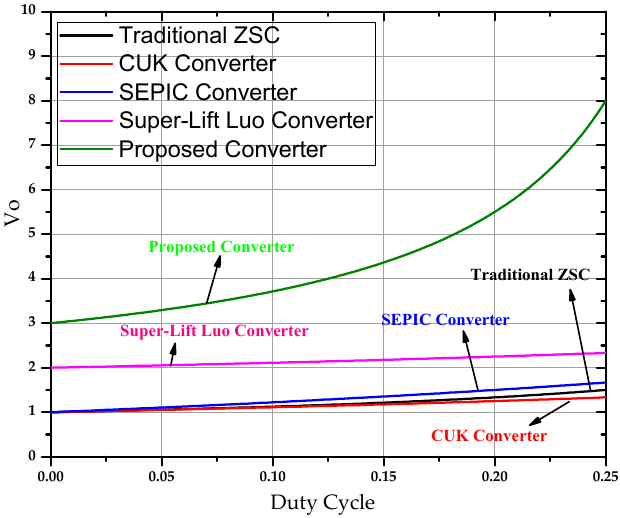
Figure 8. Comparison in the boost ability for the proposed and conventional converters.